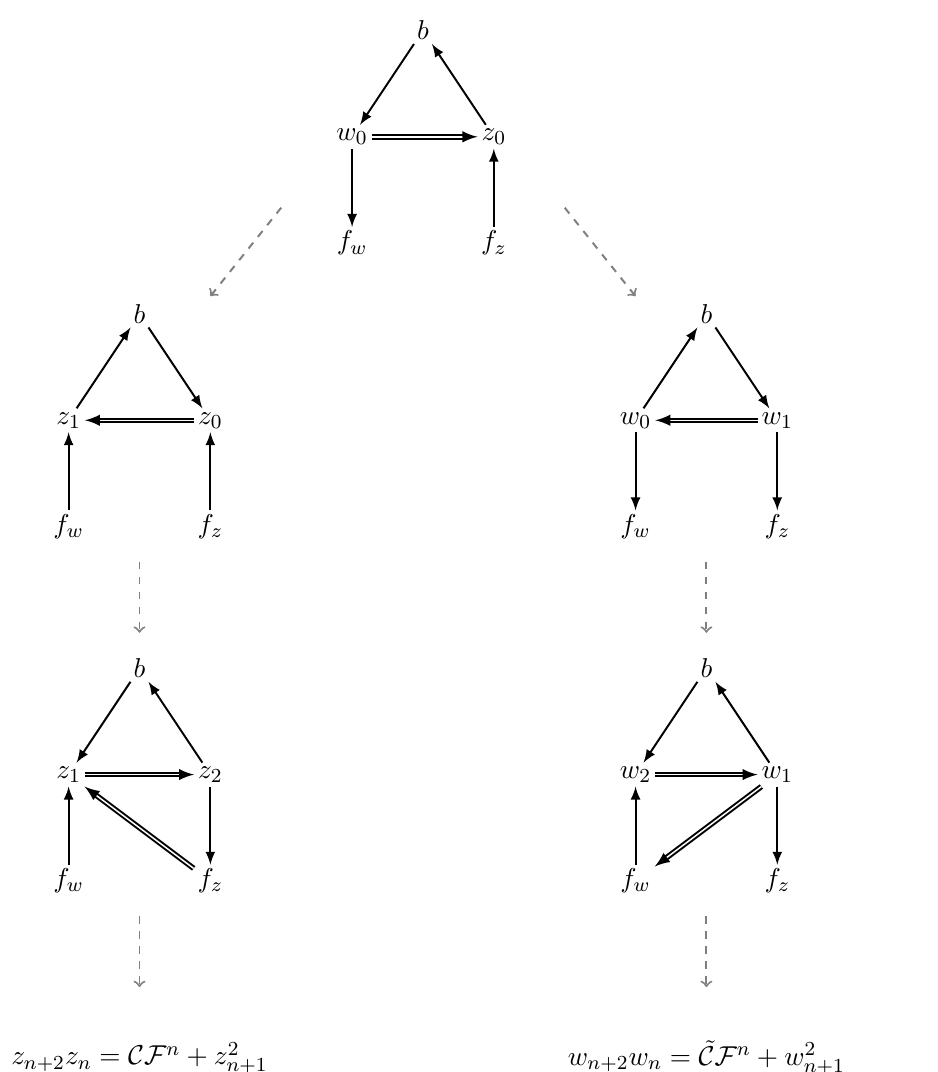
Figure 3 . The doubly infinite sequence corresponding to the embeddings of the affine A 2 cluster algebra into the Gr(4 , 8) cluster algebra. After mutating one step from the origin cluster on either node, the repeated mutations give rise to a regular recurrence